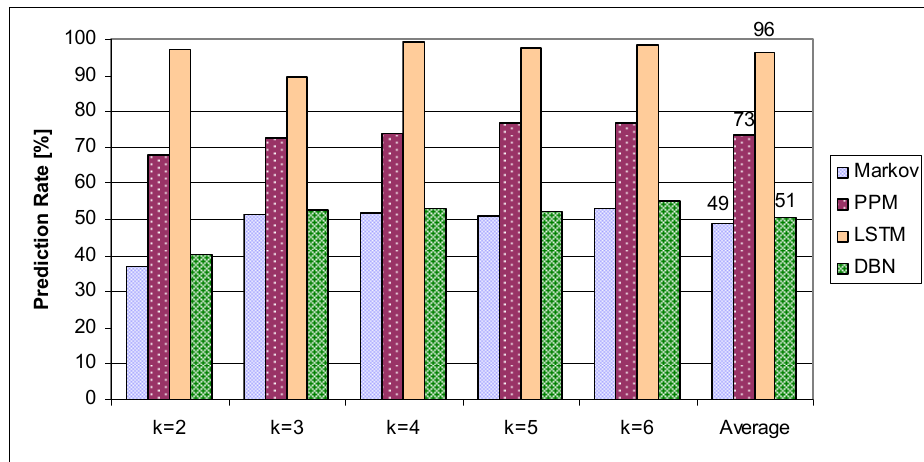
Figure 7. Prediction rate without the mood variable through k ‐ fold cross ‐ validation.